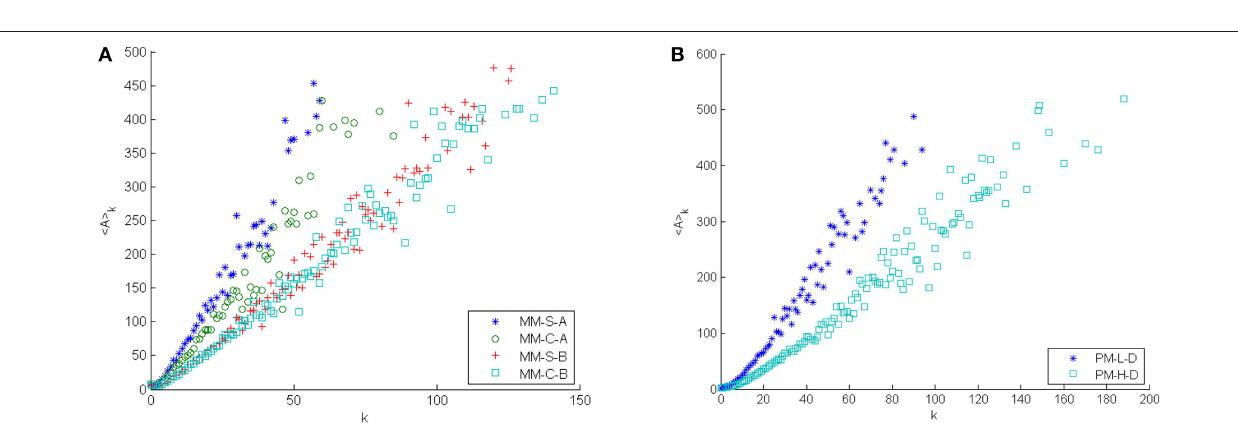
FIGURE 6 | Averaging the area for all fractures with similar degree shows a clear connection between area and degree. Results are based on 50 samples of each three-dimensional DFN model. (A) Results for the mechanical model in all limits. (B) Results for the Poissonian model in both